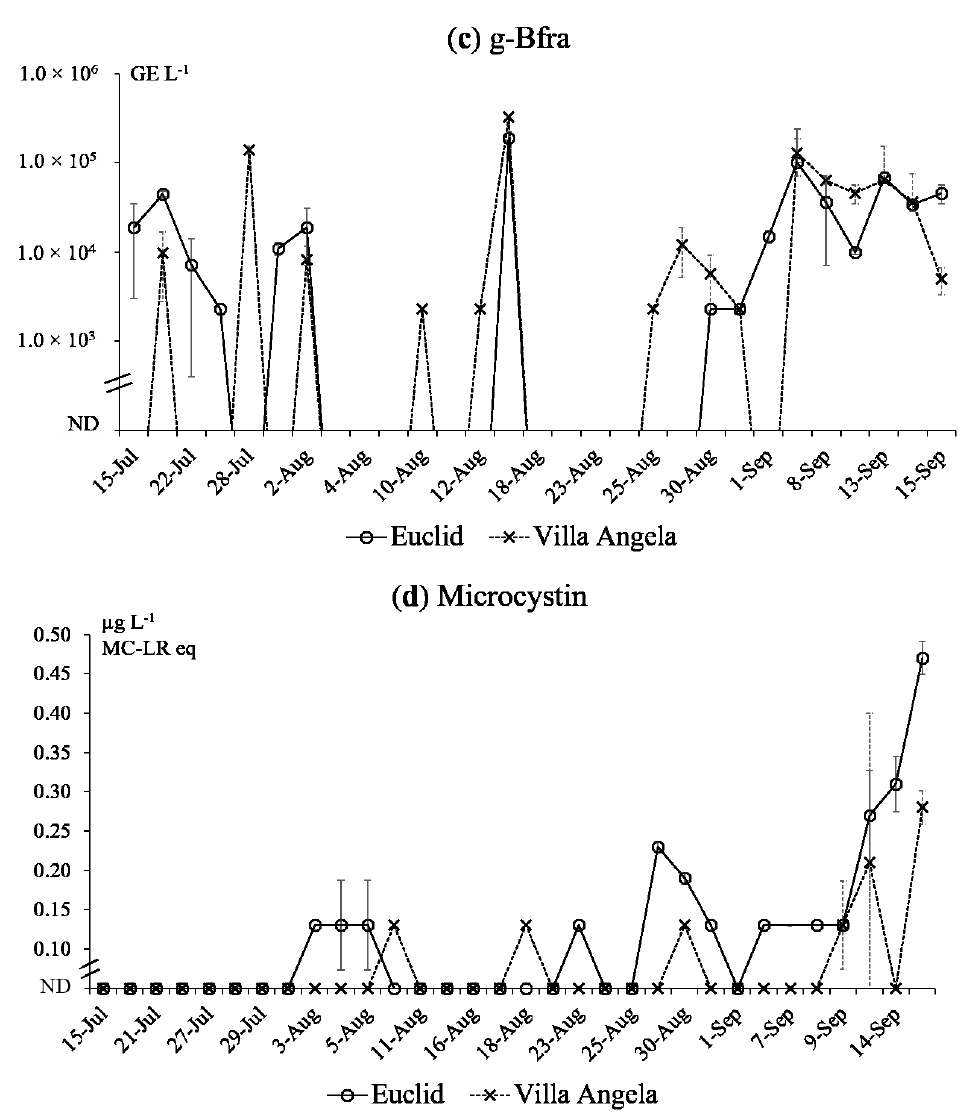
Figure 3. Profiles of the genetic marker densities and microcystin concentrations at Euclid and Villa Angela beaches from July to September in 2010. The error bars represent standard deviations (Euclid: solid lines, Villa Angela: dashed lines). The negative values of standard deviations higher than mean values are not included. g-Bfra densities in the water samples taken on 20 July, 16 August, and 2 September were not measured. ND: not